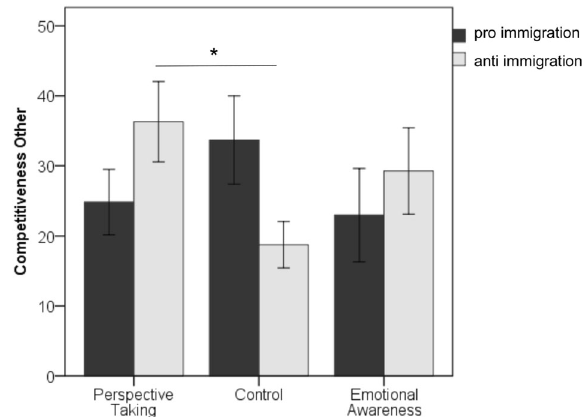
Fig. 4 Anti-immigration participants in the perspective group had a higher perception of the other ’ s competitiveness than did anti- immigration participants in the control group. The graph depicts mean scores of competitiveness of the other. Error bars depict ± 1 standard error. * p < 0.05.